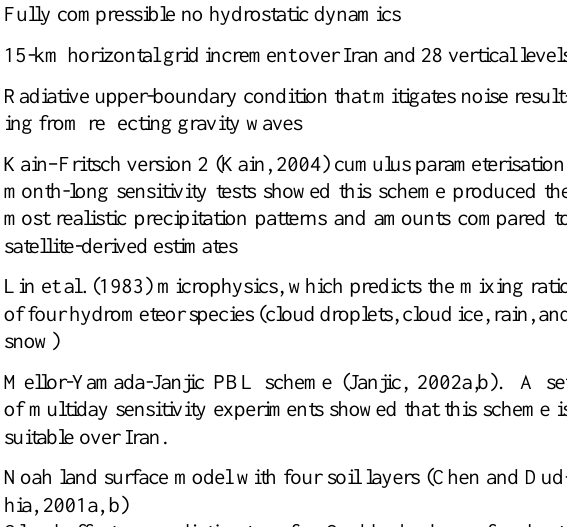
Fig. 1. Geographical position of